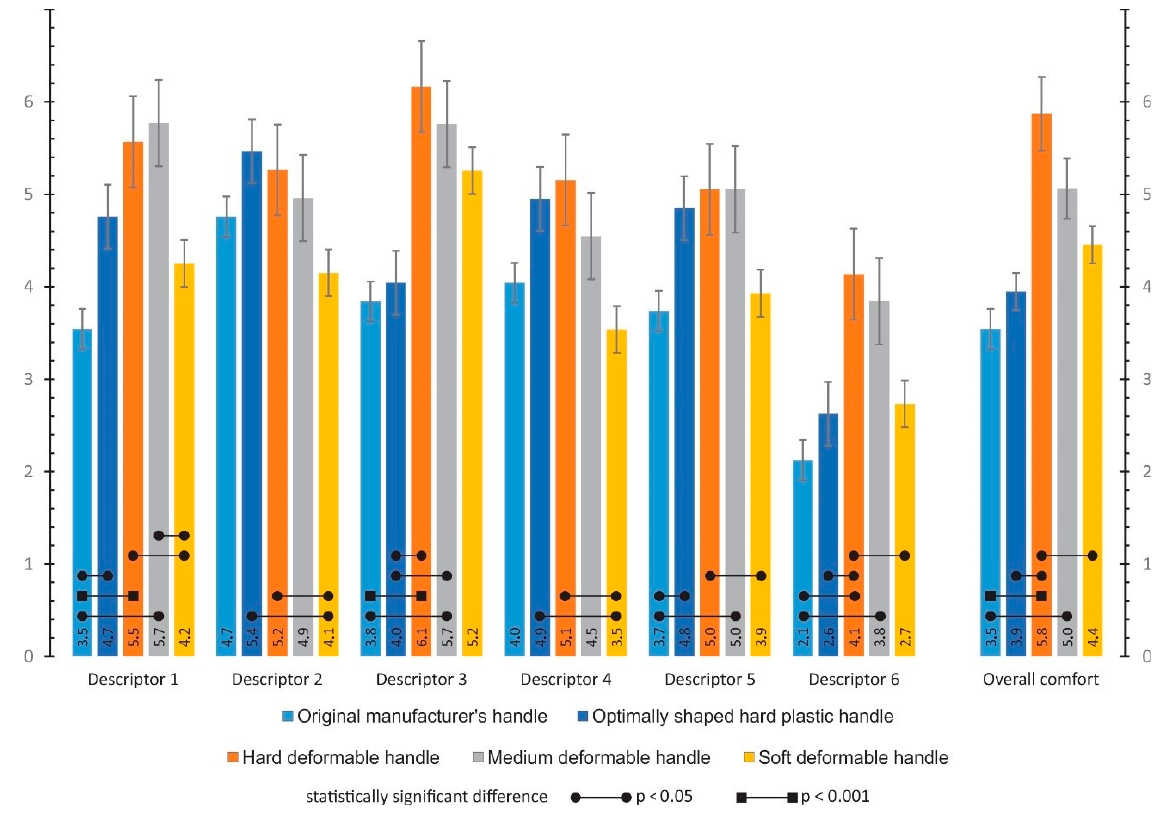
Figure 5. Results of comfort levels for comfort descriptors and overall comfort, with statistically significant differences between the handles.